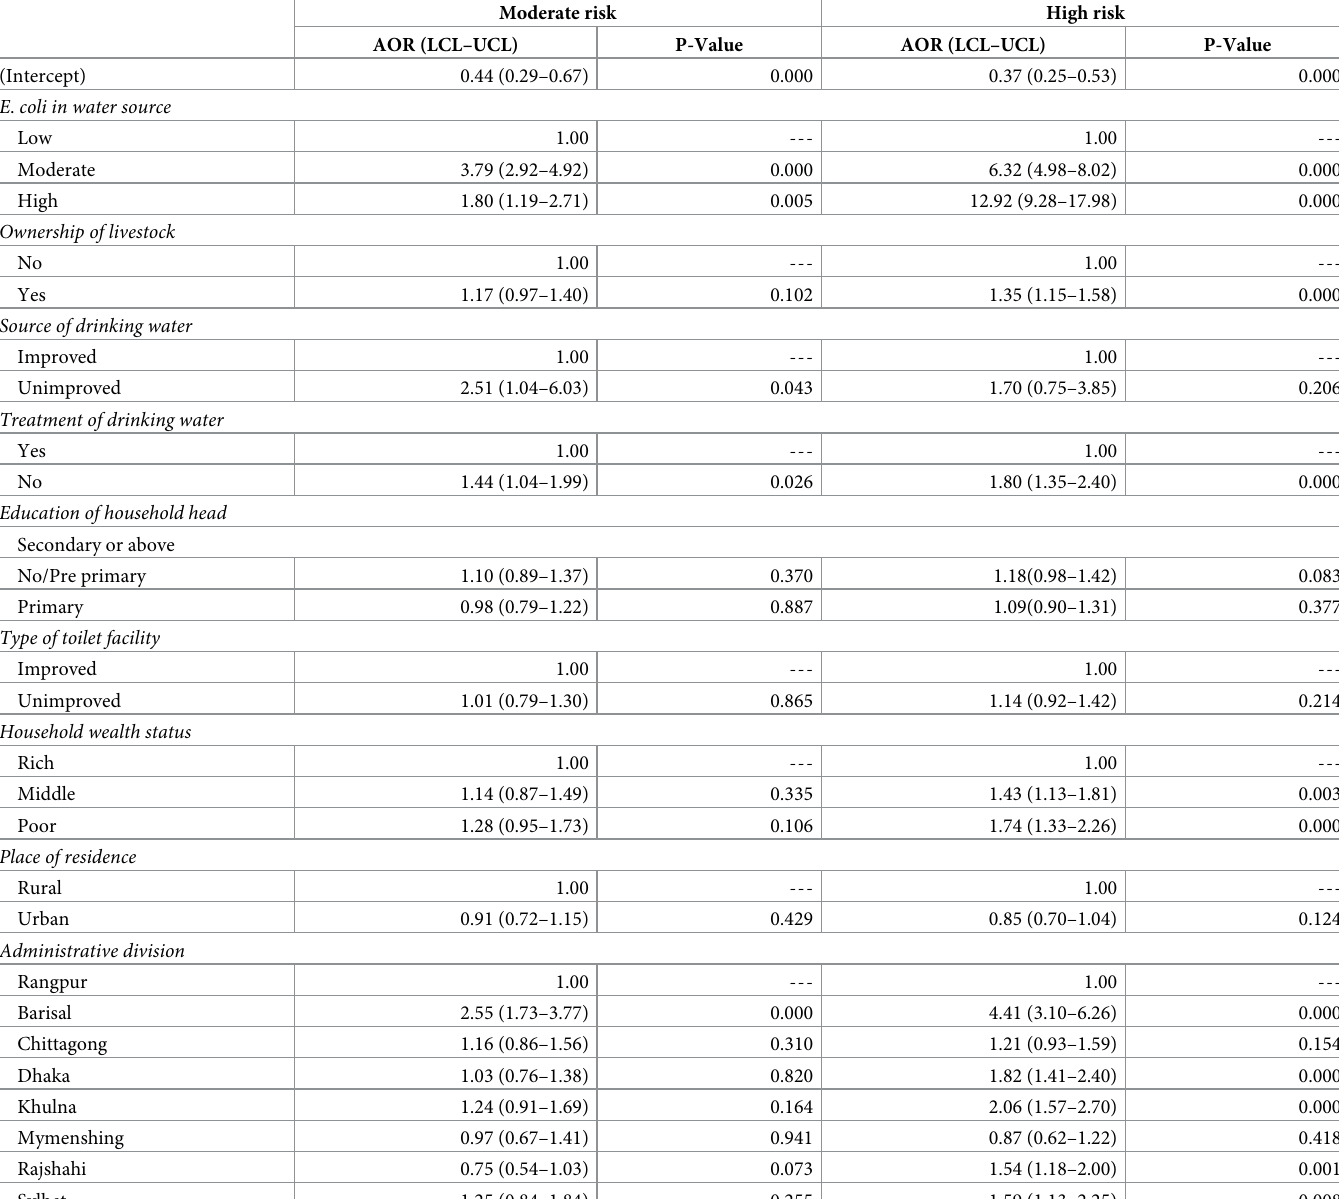
Table 2. Adjusted odds ratio (AOR), confidence intervals (CI) and P -values of moderate and high risk of E. coli contamination of drinking water at the point of use (POU) obtained from the multinomial logistic regression models. Moderate risk High risk